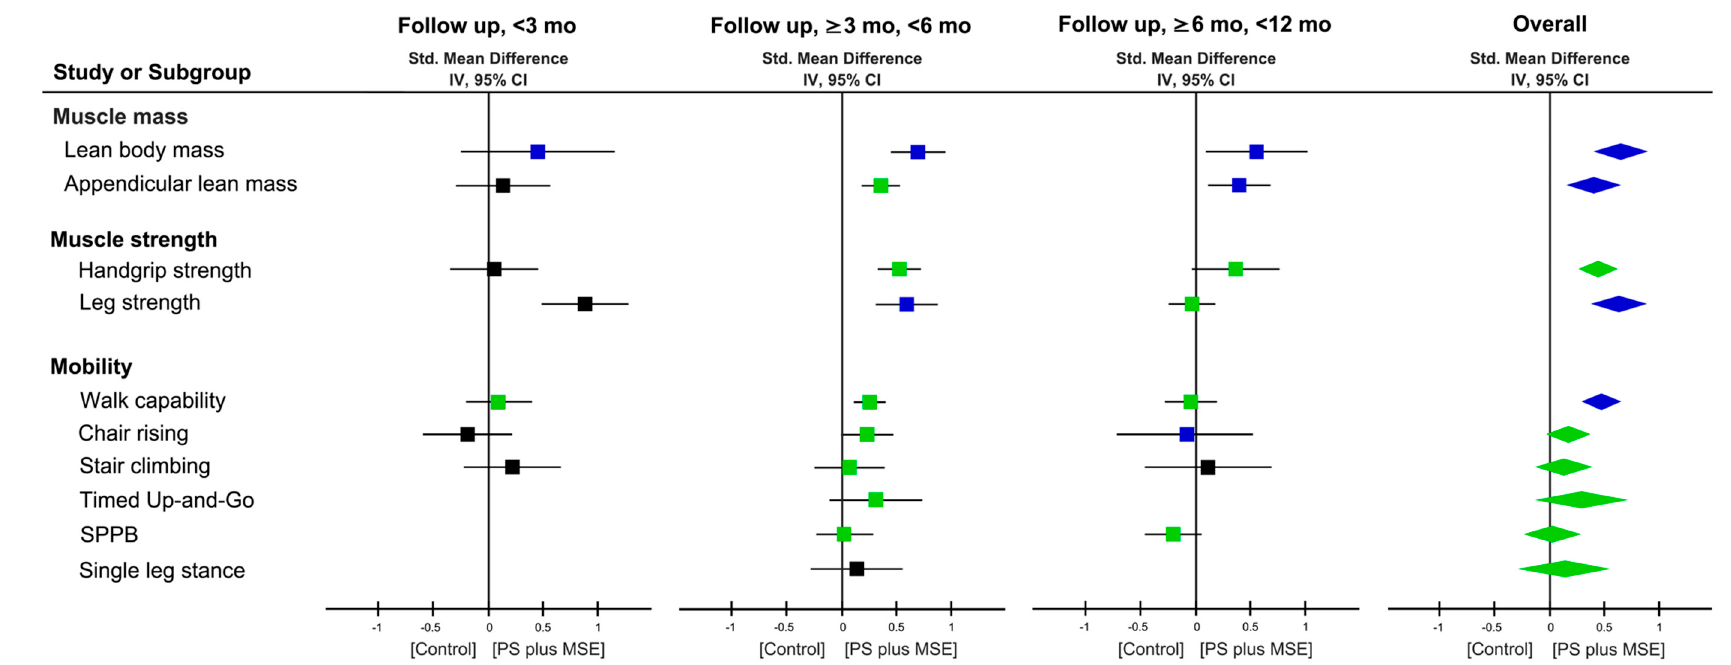
Figure 2. Forest plot summarizing effects of protein supplement (PS) plus muscle strengthening exercise (MSE) on changes of muscle mass, body composition, and physical function at each follow up duration. Each point estimate at each follow up duration (square) and during an overall duration (diamond) presents the combined effect (standard mean difference) of the outcome measure where indicated, with 95% CI (horizontal line). Results plotted on the right-hand side indicate effects in favor of PS plus Ex. The combined effects analyzed by a fixed- or random-effect model are denoted by green and blue colors, respectively; and a black colored square denotes that the combined effect is derived from a single study. 95% CI = 95% confidence interval; Std = standard; IV = inverse variance; SPPB = short physical performance battery.